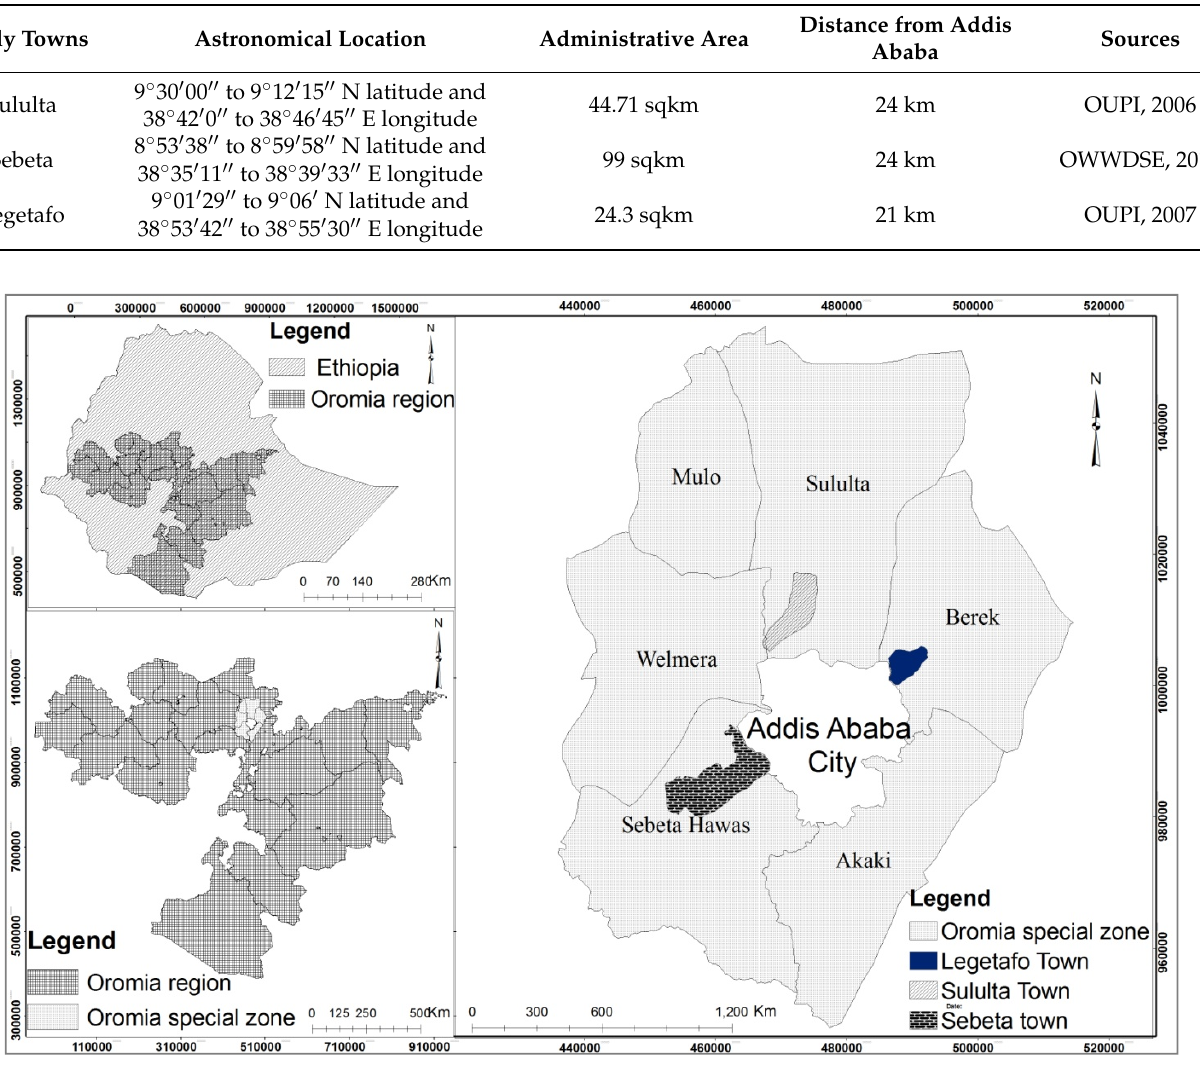
Figure 1. Map of the study area.